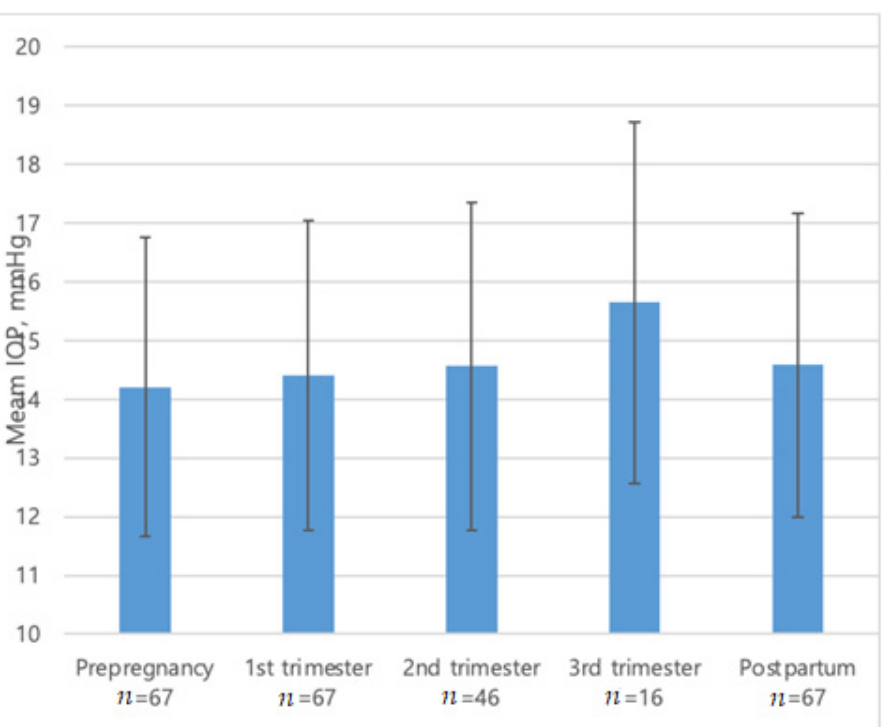
Figure 1. Mean intraocular pressure (IOP) of study subjects. There was no difference in IOP between the five follow-up periods by Kruskal–Wallis test ( p = 0.32).